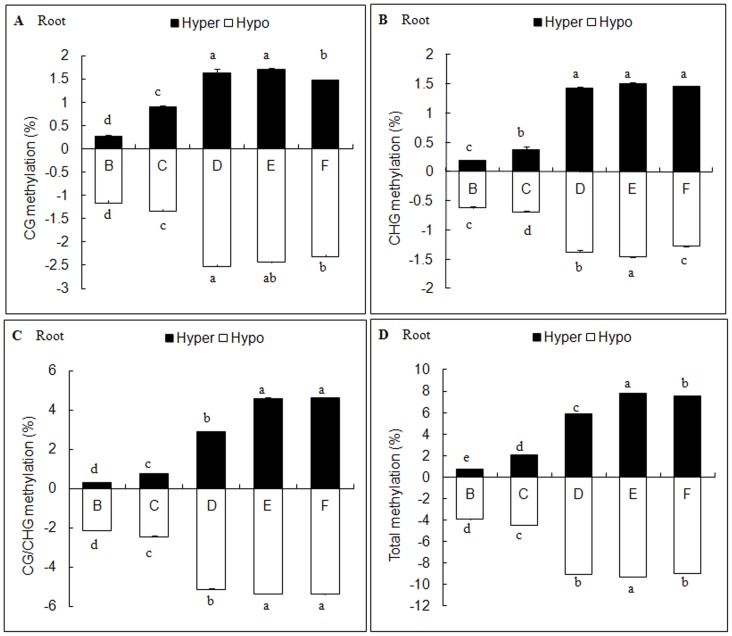
Effects of different salt stresses on methylation variation in C.virgata roots.B: NaCl, C: Na2SO4, D: NaHCO3, E: Na2CO3, F: Mix. Data represent means ±S.E. of four replicates. Different lower-case letters represent significant difference among treatments at the 5% level, according to least significant difference (LSD) test.